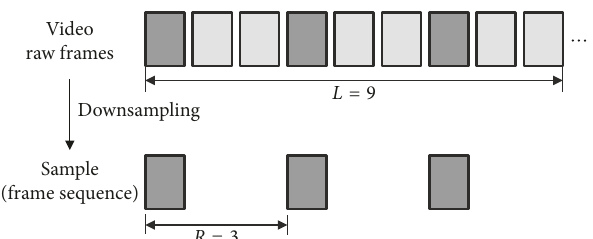
Figure 12: Definition of segmentation length ( L ) and temporal resolution ( R